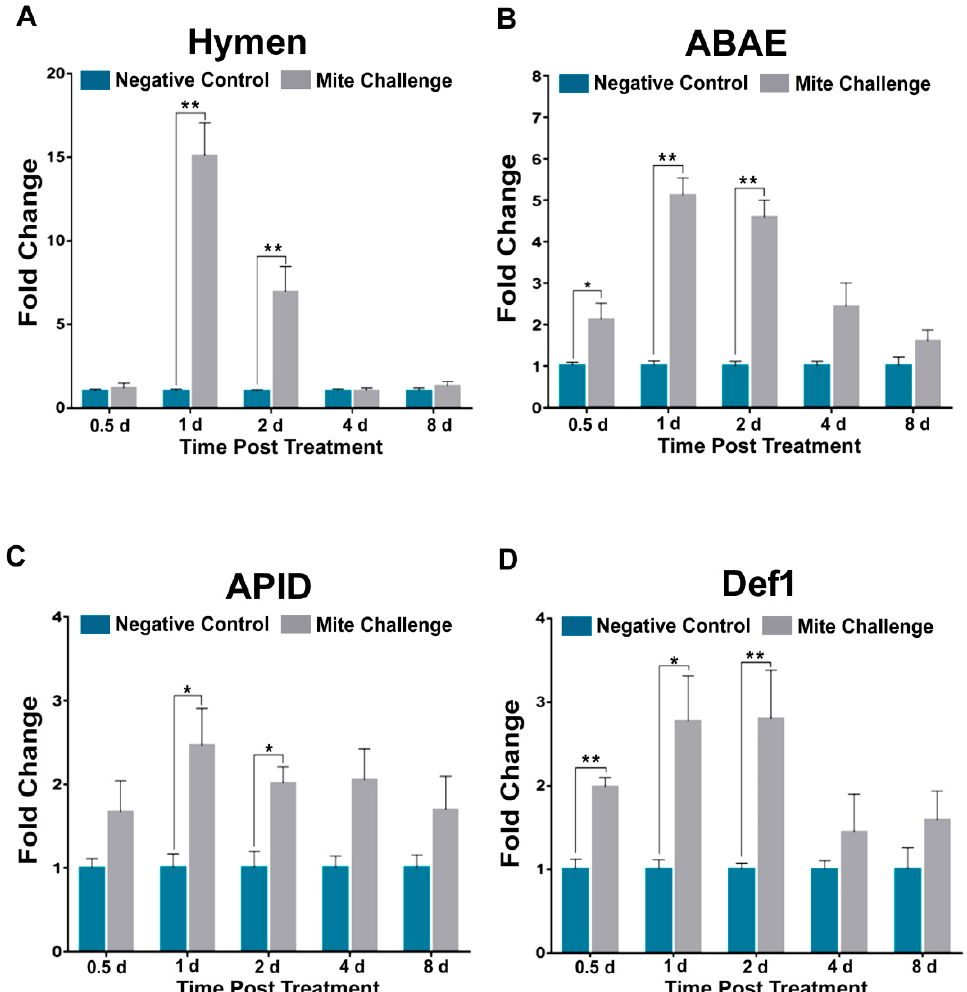
Figure 2. Fold change of the transcription profiles for Toll pathway AMPs downstream of Dorsal signaling between the negative control (without Varroa challenge) (cyan) and the bees challenged with Varroa mites (grey) at different time points post treatment (days). ( A ) Hymenoptaecin (Hymen), ( B ) Abaecin (ABAE), ( C ) Apidaecin (APID), and ( D ) Defensin 1 (Def1) showing similar transcription profiles for their activator Dorsal. (* p < 0.05, ** p < 0.01).